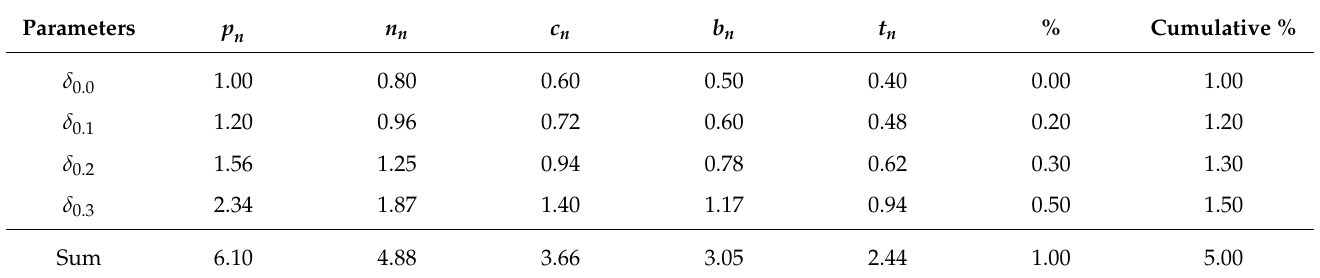
Table 4. α i values that affect the cost of the unit healthcare resource to the ED